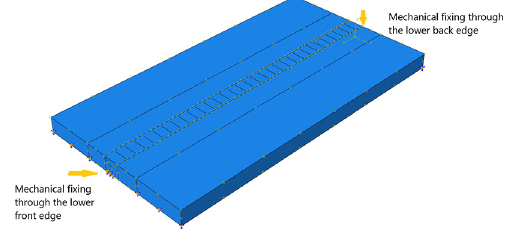
Figure 5. Boundary conditions for mechanical attachment